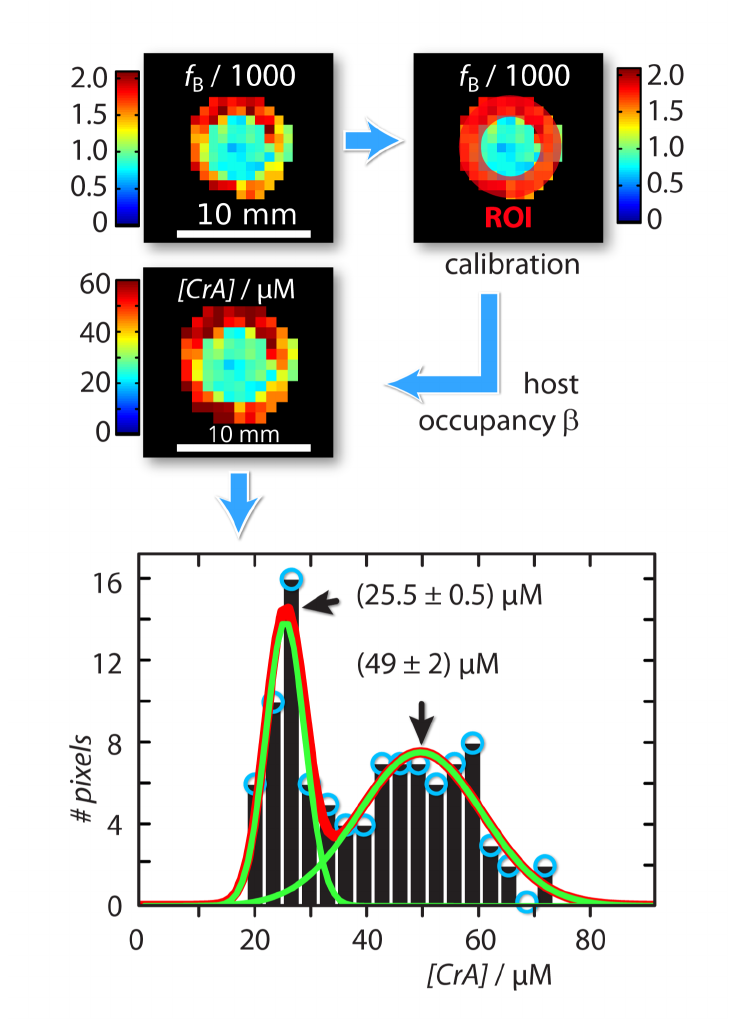
Figure 3. Workflow of absolute concentration mapping starting with the ratio of bound and free Xe, f B , at the top left: The host occupancy, β , was calibrated with the Hyper-CEST response produced by the known reference sample in the outer compartment (red region-of-interest (ROI)) according to β cal = f B × ([Xe]/[CrA-ma] OC,known )=9%. The unknown CrA-ma concentration in the inner compartment was then calculated with [CrA-ma] IC,unknown = ( f B / β cal ) × [Xe]. The Gaussian line fitted histogram of the [CrA-ma] map identified two different concentration populations around (25.5 ± 0.5) µ M and (49 ± 2) µ M (green solid lines; linear combination: red solid